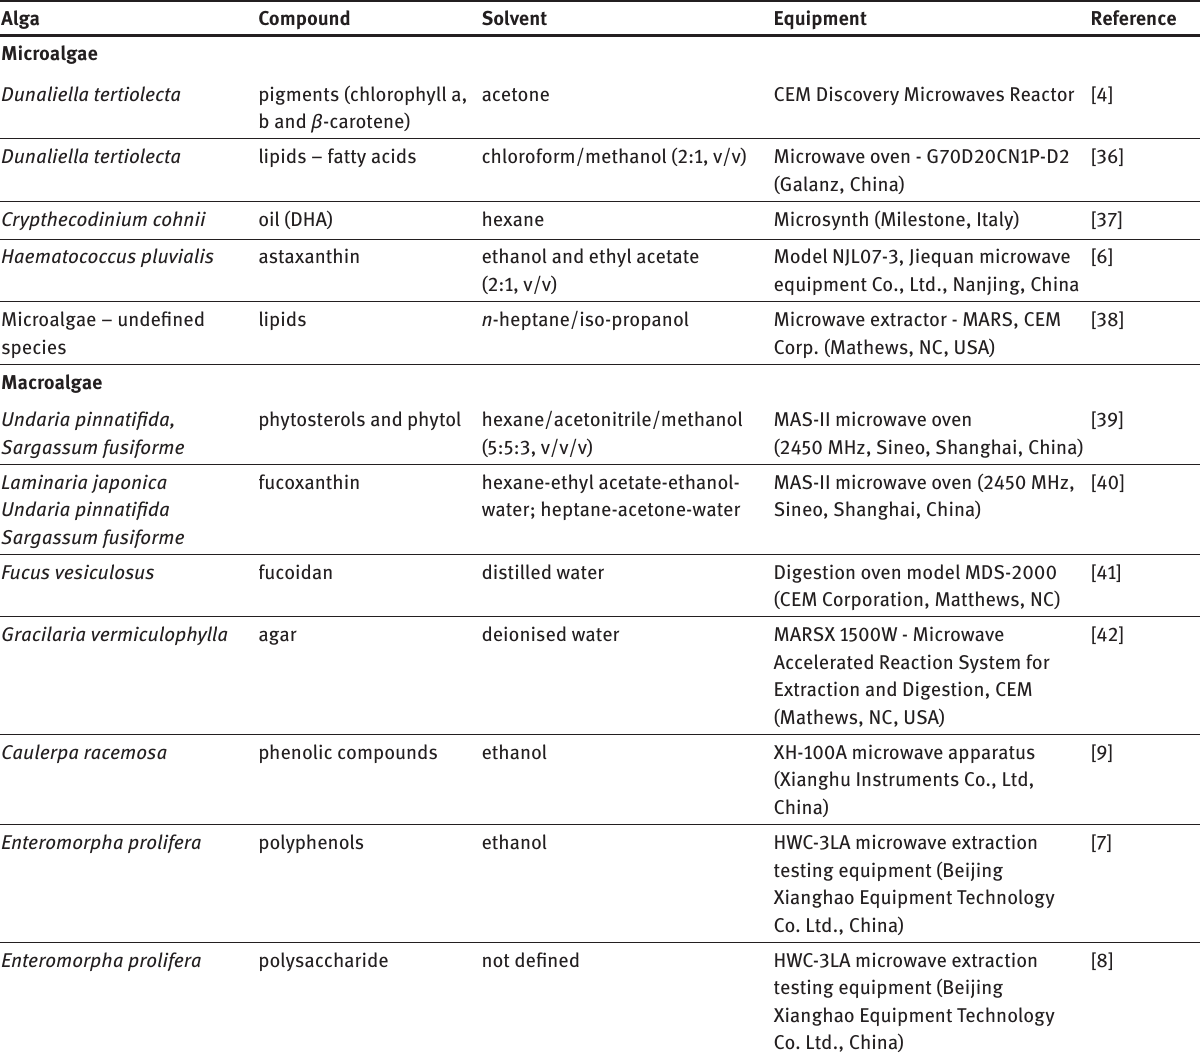
Alga Compound Solvent